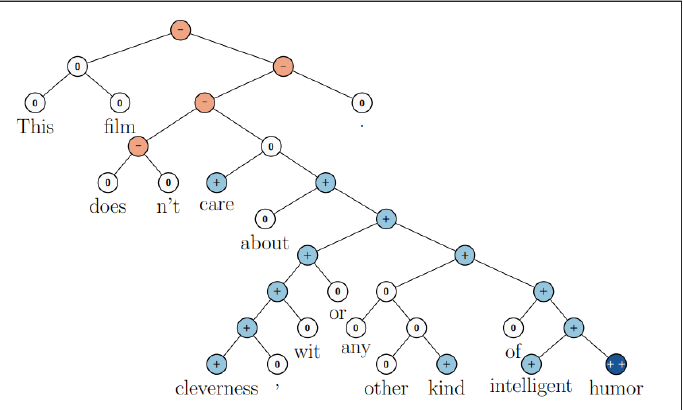
Figure 1. Sample sentiment tree from SST-5 (figure from the original paper [11]).